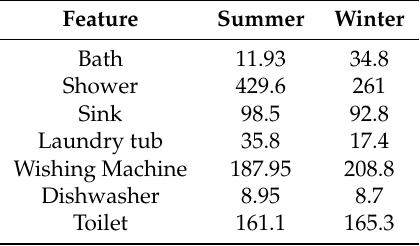
Table 3. Water daily usage time for different features (seconds).